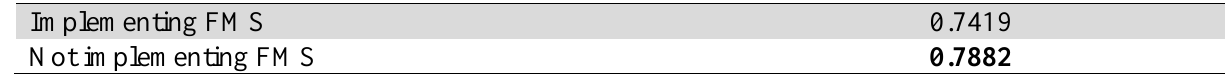
The Ranked Alternative Implementing